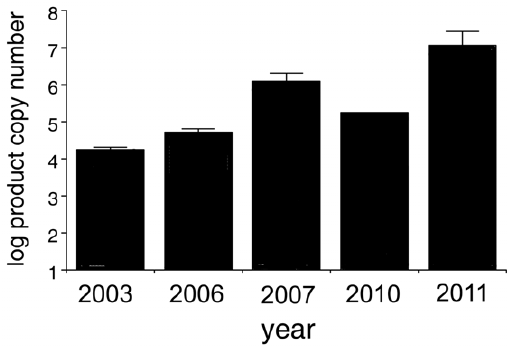
Figure 7. Telomerase activity increases over time in DFT cell lines (P=0.037). The five cell lines originated from tumour samples collected in 2003, 2006, 2007, 2010 and 2011. Bars represent standard errors between technical repeats